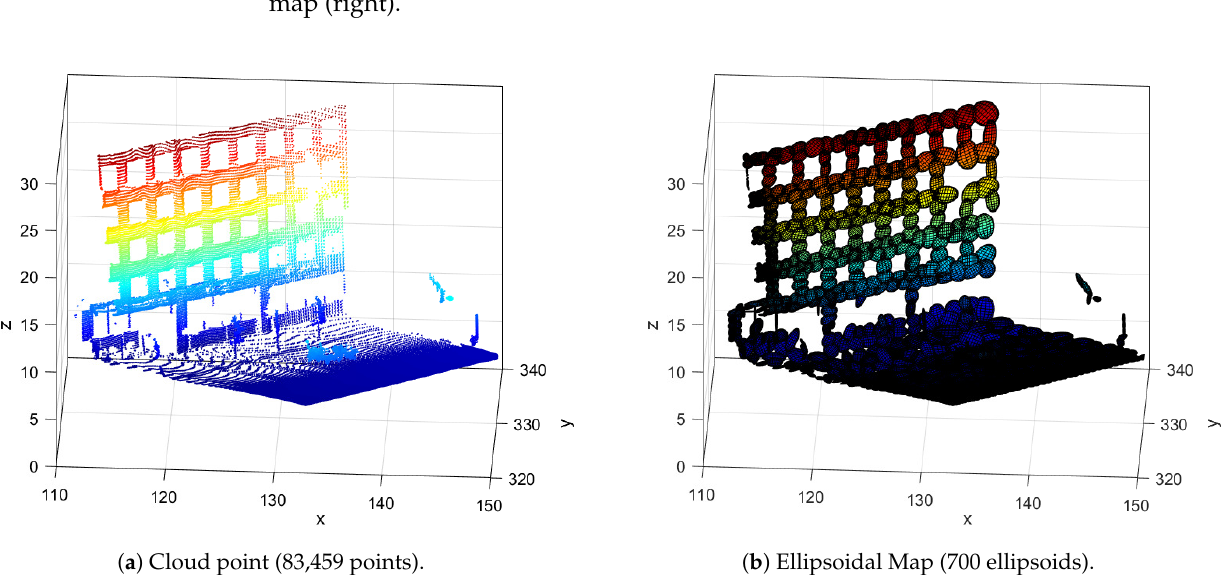
Figure 1. Example of an ellipsoidal map generated with the ellipsoidal mapping algorithm presented in